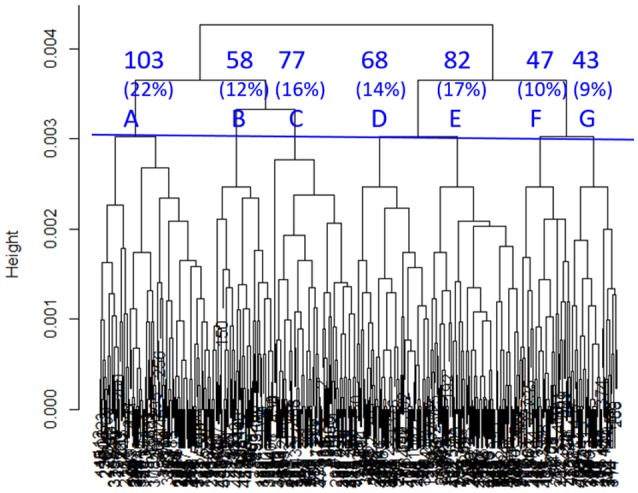
Dendrogram built by SHC. Seven clusters (A–G) were used in subsequent analyses. The percentages refer to the proportions of TRACK-TBI Pilot patients in each cluster.